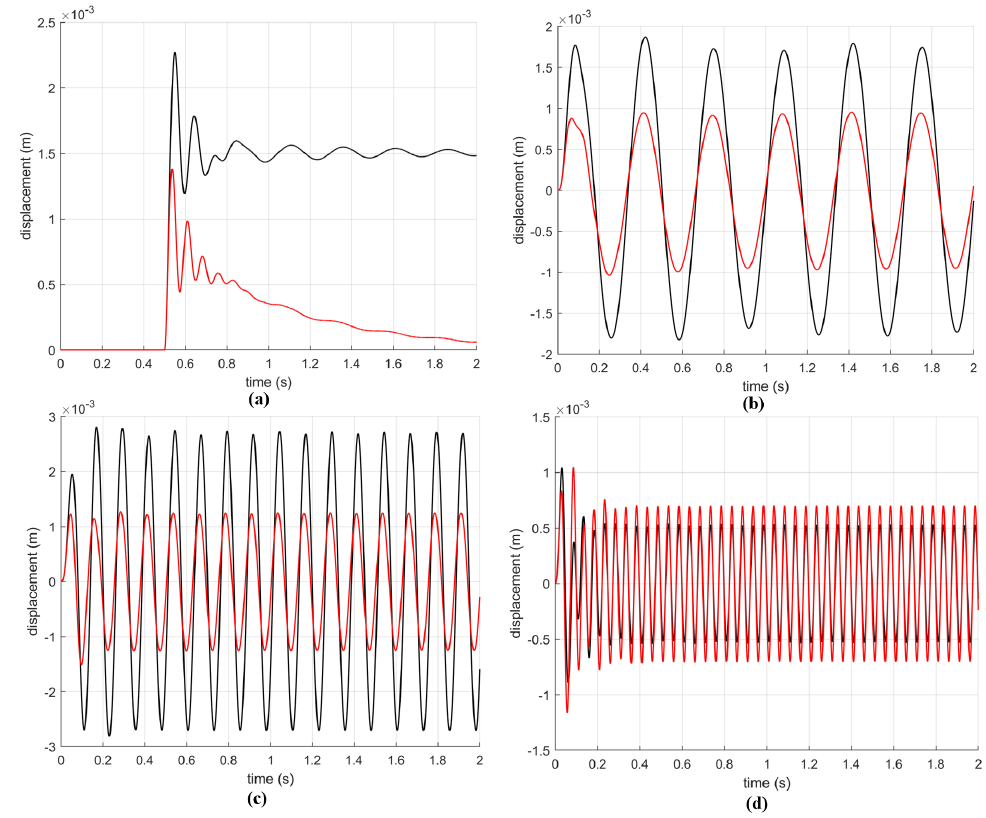
Figure 14. PI controller simulation results in Simulink. Black curves are open loop responses, and red curves are PI controller responses. ( a ): step response. ( b ): 3 Hz sine response. ( c ): 8 Hz sine response. ( d ): 20 Hz sine